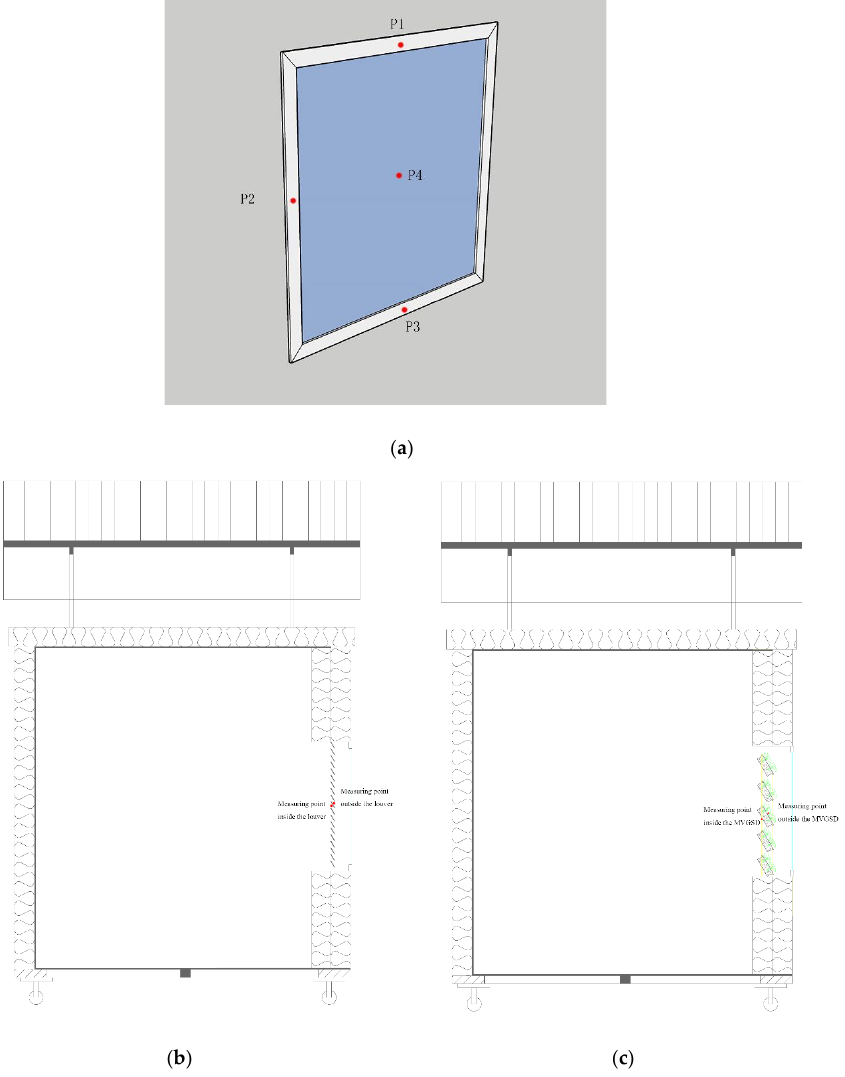
Figure 5. Measuring points of windows ( a ), louver ( b ), and MVGSD ( c